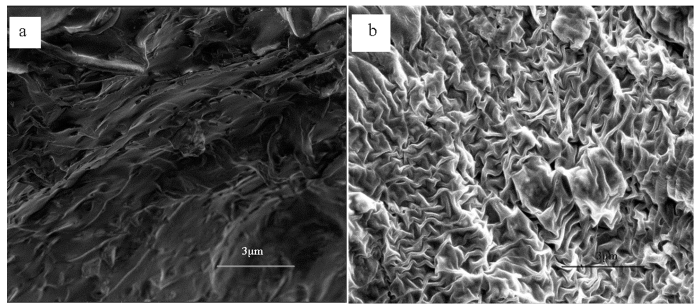
Figure 1. SEM image of plugging agent: ( a ) without sericite; ( b ) with sericite.